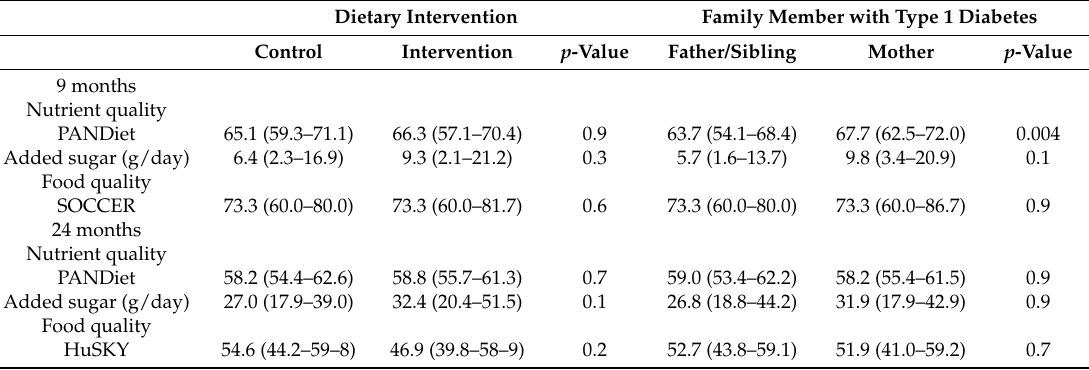
Table 2. Nutrient and food intake quality in children aged nine and 24 months according to dietary intervention and family history of type 1 diabetes in the BABYDIET